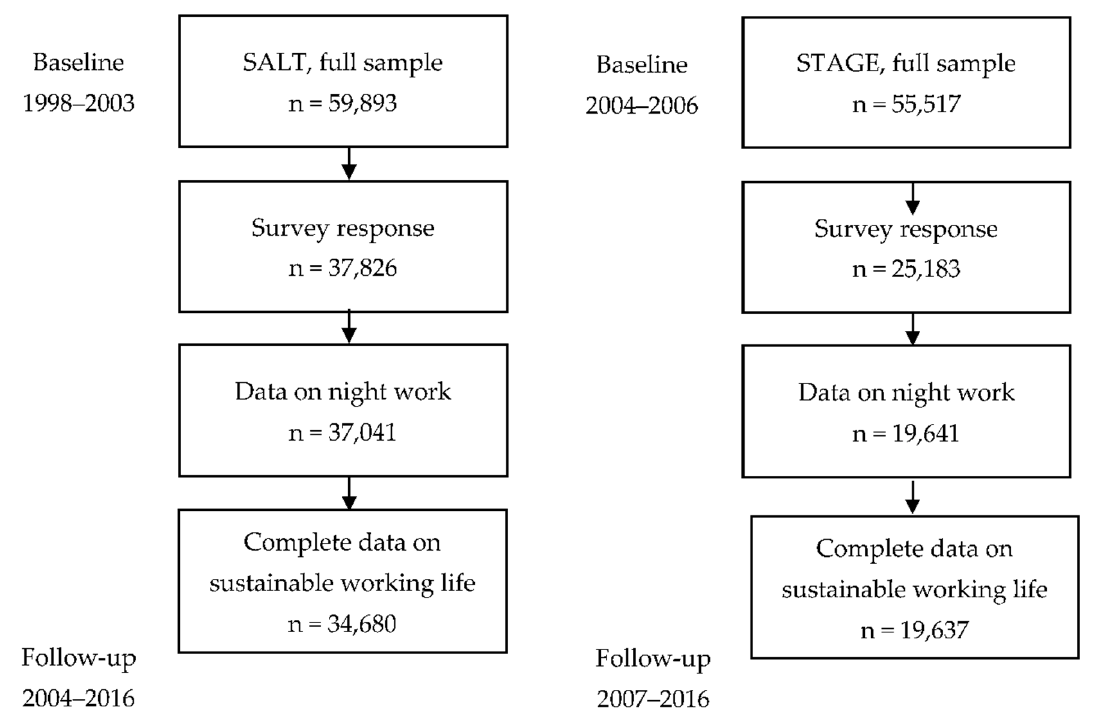
Figure 1. Sample definitions of the SALT and STAGE cohorts and their baseline and follow-up times.